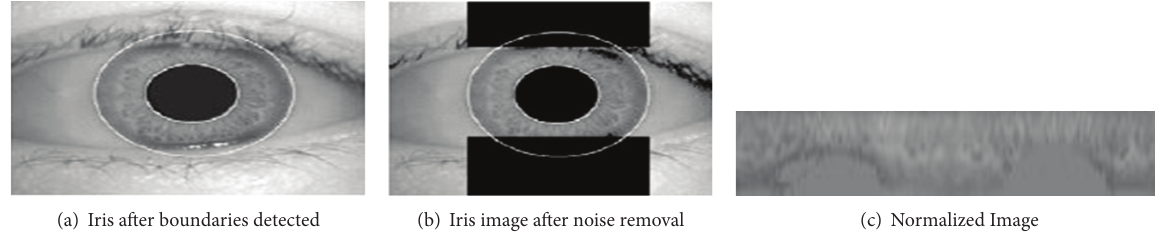
Figure 3: Iris Localization, segmentation, and normalization